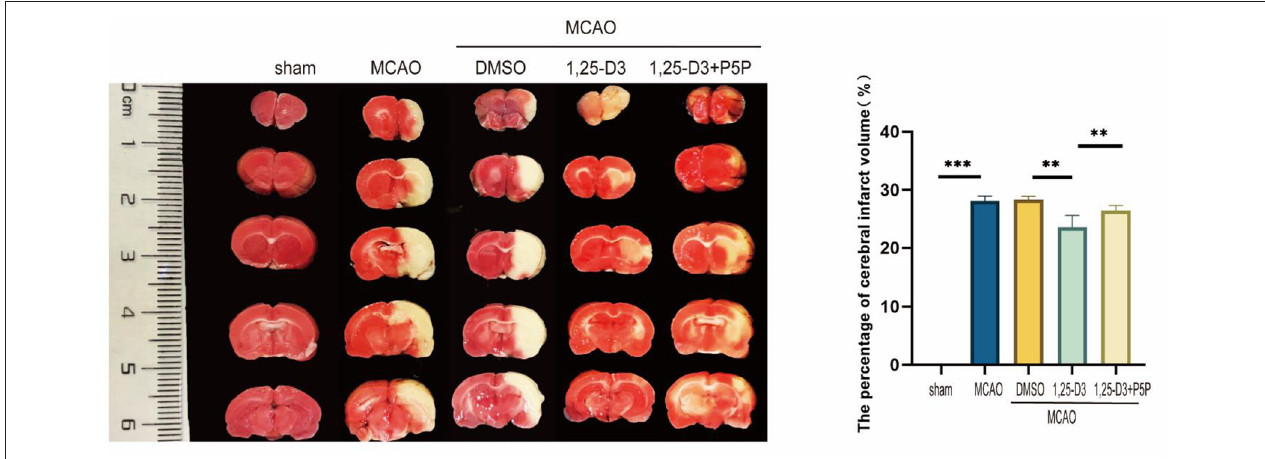
FIGURE 1 | 1,25-D3 reduced the volume of infarct regions in rats 3 days after stroke. Data were represented as Mean ± SEM, n = 5 per group, * p < 0.05, ** p < 0.005, *** p < 0.001. MCAO, middle cerebral artery occlusion; DMSO, dimethyl sulfoxide; P5P, antagonist of VDR; 1,25-D3, 1 α ,25-dihydroxyvitamin D3.